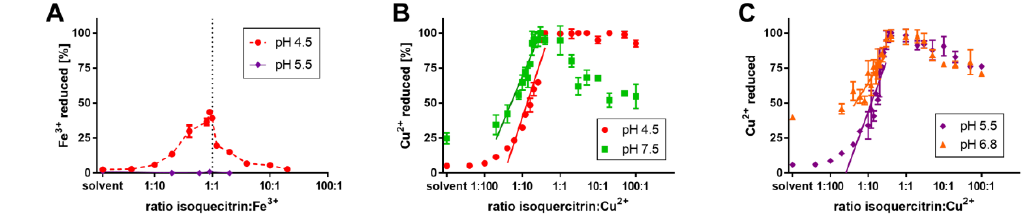
Figure 5. Metal reduction by isoquercitrin: ( A ) ferric ion reduction after 5 min. Data for pH 6.8 and 7.5 are not shown since there was no reduction similarly demonstrated for pH 5.5. ( B , C ) cupric reduction after 5 min. Isoquercitrin in respective buffers was mixed with Fe 3+ or Cu 2+ ions (the final concentration of both was 50 μM) and the indicator ferrozine or BCS was added, respectively. The absorbance was measured immediately and after 5 min. The percent reduction was calculated vs .